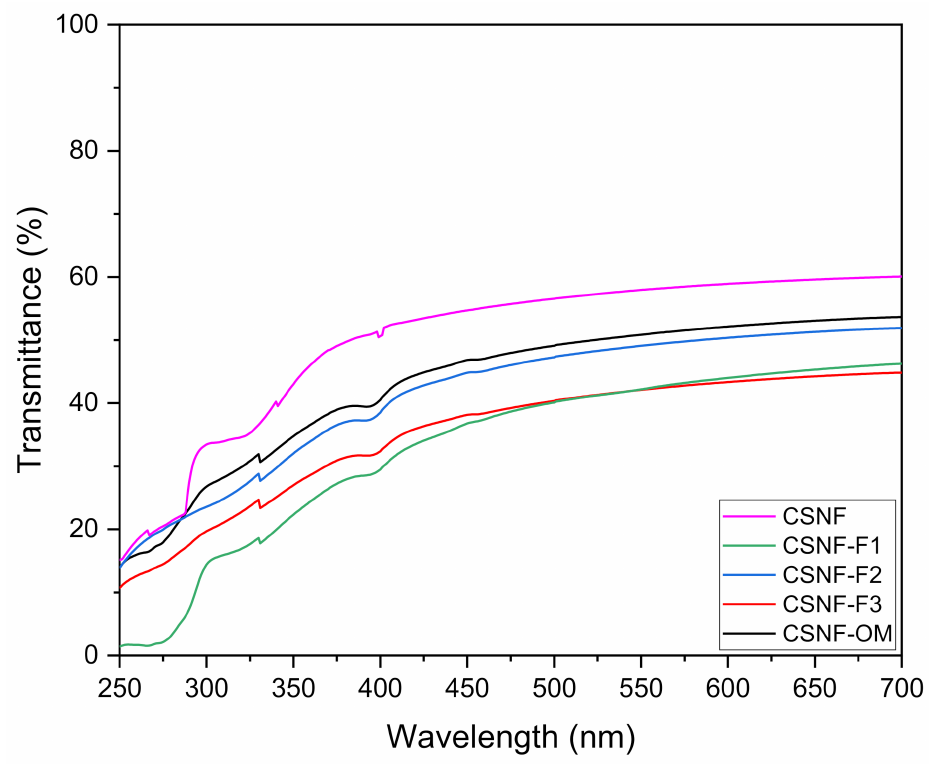
Figure 2. UV-Vis spectra (700–250 nm) of the nanocomposites